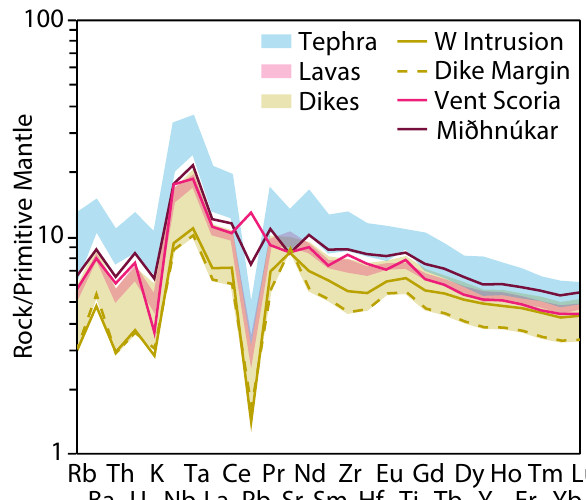
Figure 11: Primitive mantle normalized multielement diagram for Thríhnúkagígur samples show that the tephra are uniformly enriched in incompatible trace element relative to the lavas or dikes and that the lavas are homogeneous relative to their cor- responding intrusive rocks. Primitive mantle normalization val- ues are from [Sun and McDonough